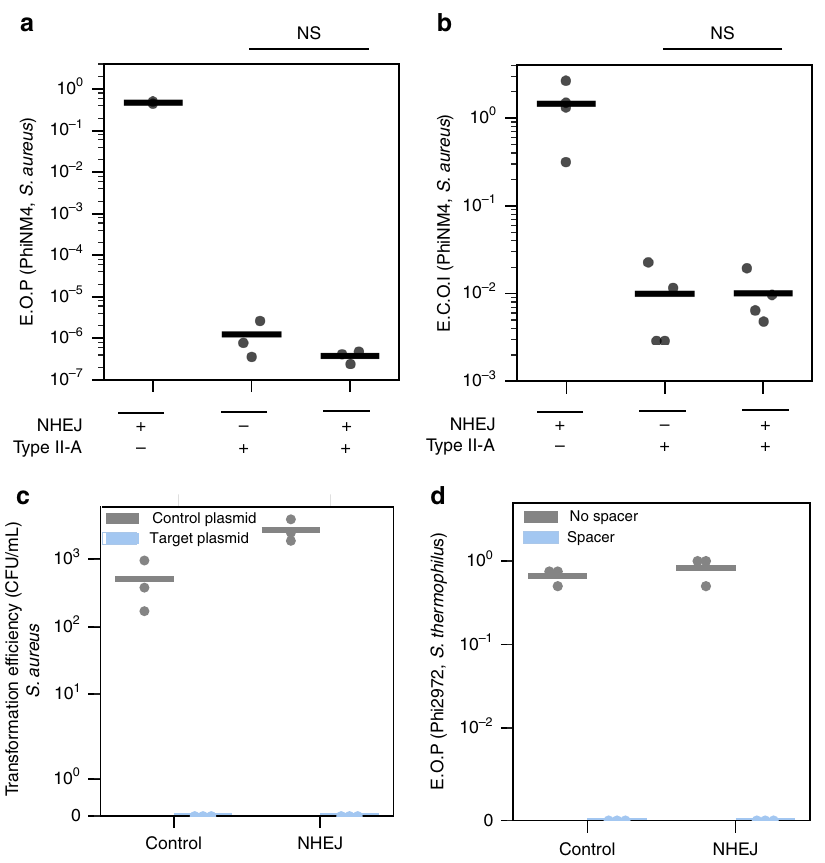
Fig. 2 The B. subtilis NHEJ system has no measurable effect on type II-A CRISPR-Cas interference. a Resistance to phage phiNM4 provided by the S. pyogenes CRISPR-Cas9 system in S. aureus in the presence (pAB1) or absence (pE194) of the NHEJ system from B. subtilis ( n = 3, mean, NS double-sided t test P = 0.9999). b Ef fi ciency of center of infection (ECOI), i.e., the proportion of cells that produce at least one functional phage particle, in the presence (pAB1) or absence (pE194) of the NHEJ system ( n = 4, mean, NS double-sided t test P = 0.9998). c Transformation ef fi ciency of plasmid pT181 either empty or carrying a target sequence (pAB2) in S. aureus RN4220 cells expressing the CRISPR-Cas system from plasmid pMD021 in the presence (pAB1) or absence (pE194) of the NHEJ system from B. subtilis ( n = 3, mean). d EOP of phage Phi2972 on a bacteriophage-insensitive mutant of S. thermophilus DGCC7710 carrying a spacer against Phi2972. Cells express either the B. subtilis NHEJ system from plasmid pAB66 or a control GFP from plasmid pAB69 ( n = 3,